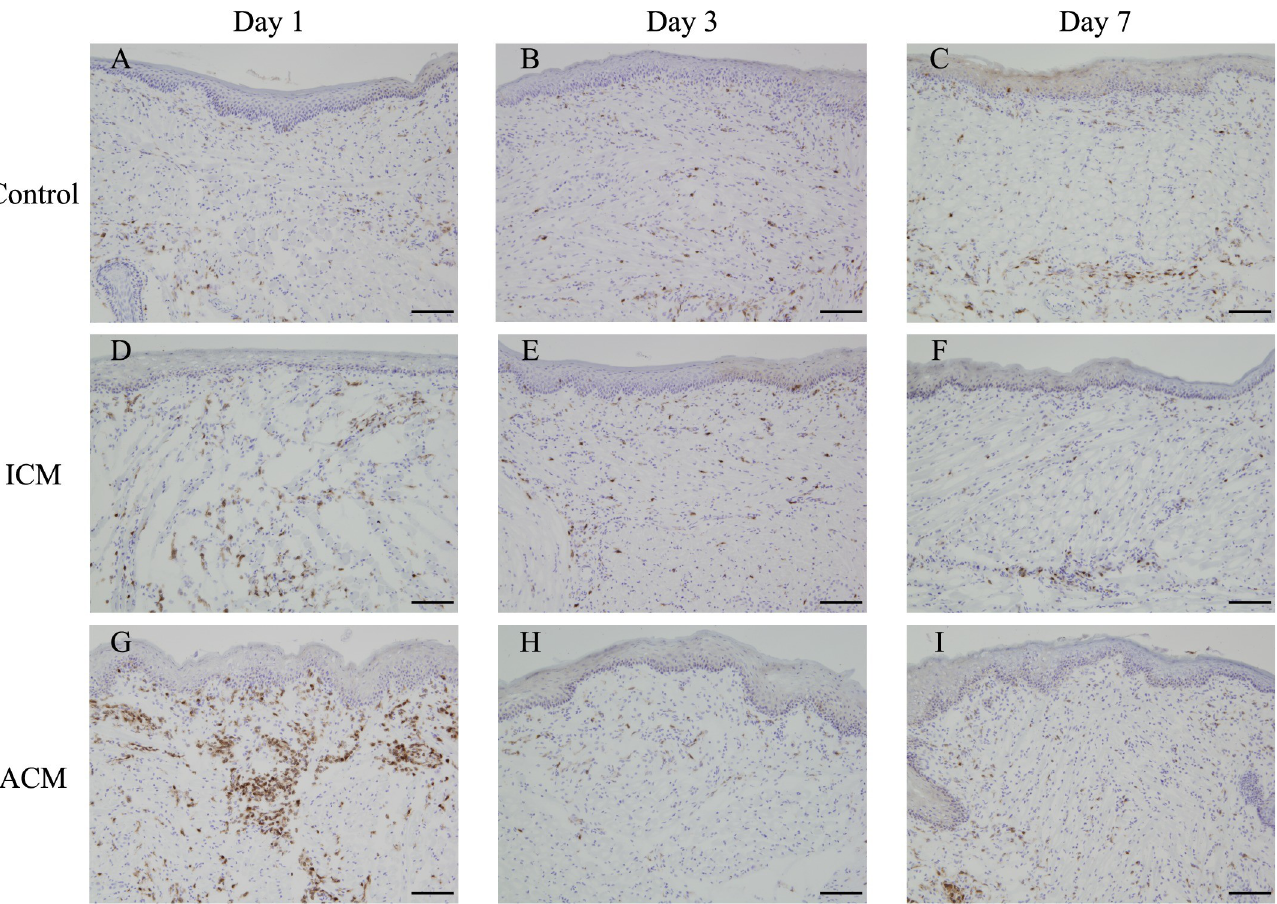
Fig 4. Immunohistochemical analyses of antigen-presenting cells in the oral mucosa of Ni-induced allergic mice. Frozen buccal mucosa sections were stained with anti-F4/80 antibodies at days 1, 3, and 7 after challenge. At day 1 after challenge, abundant infiltration of macrophages into the epithelial basal layer and the upper dermis was observed in ACM mice (G). Scale bar = 10 μ